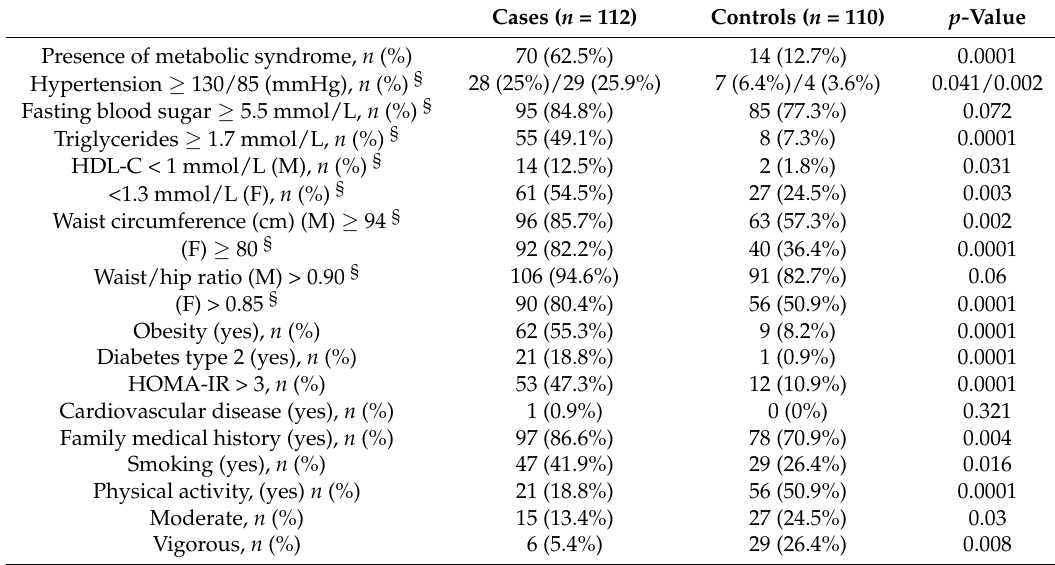
Table 2. Comparison of clinical and environmental data between controls and cases.